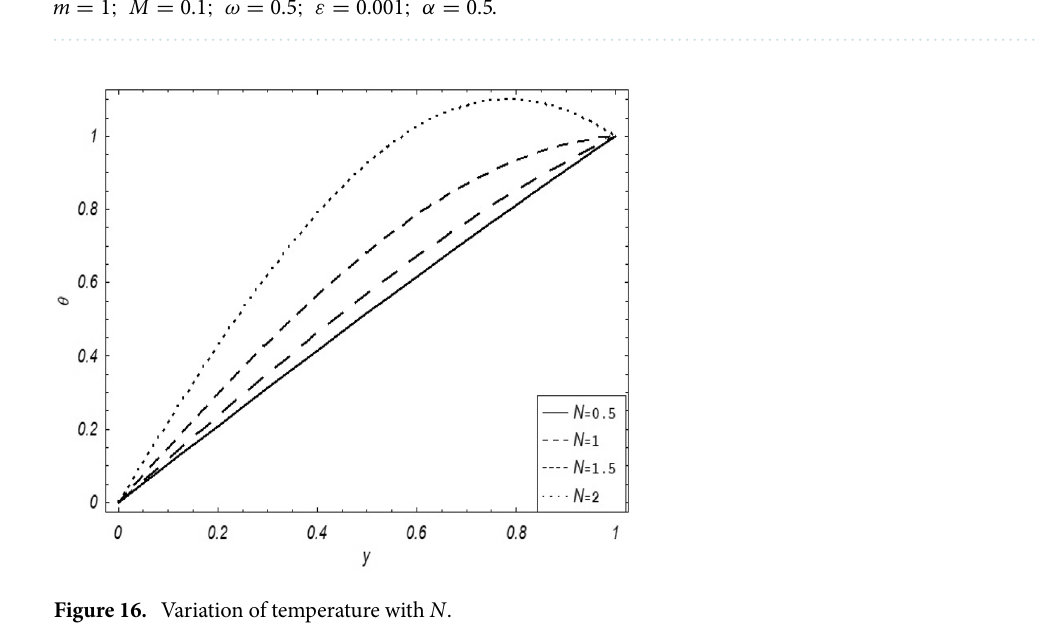
Figure 15. Evolution of W with various values of Re if t = 1 ; Gr = 2.5 ; N = 0.7 ; K = 0.5 ; η = 2 � = 0.5 ; m = 1 ; M = 0.1 ; ω = 0.5 ; ε = 0.001 ; α = 0.5 .